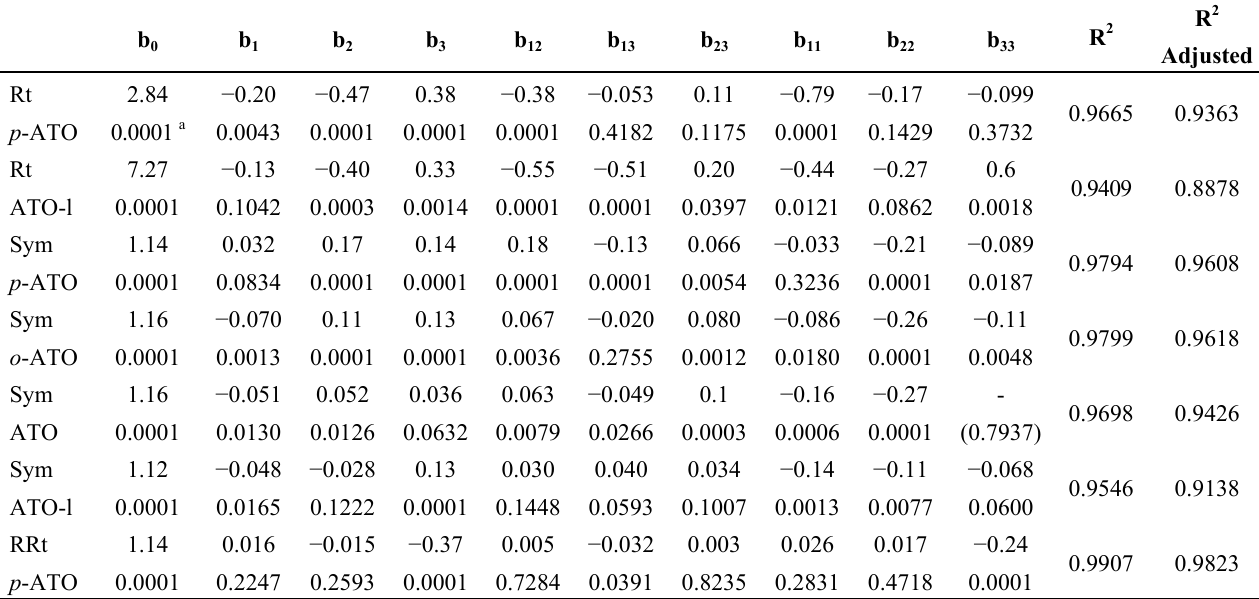
Table 2. Response models with p-value and statistical parameter (R 2 ) obtained from